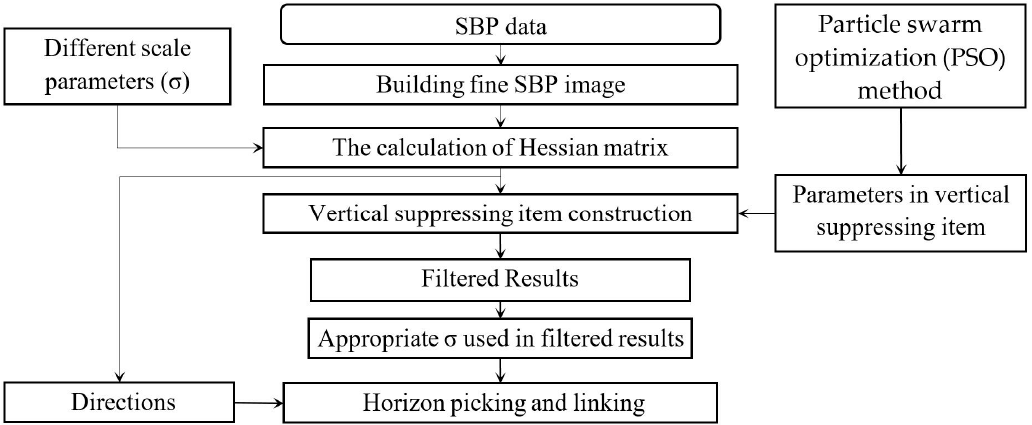
Figure 1. Flowchart of the proposed method.